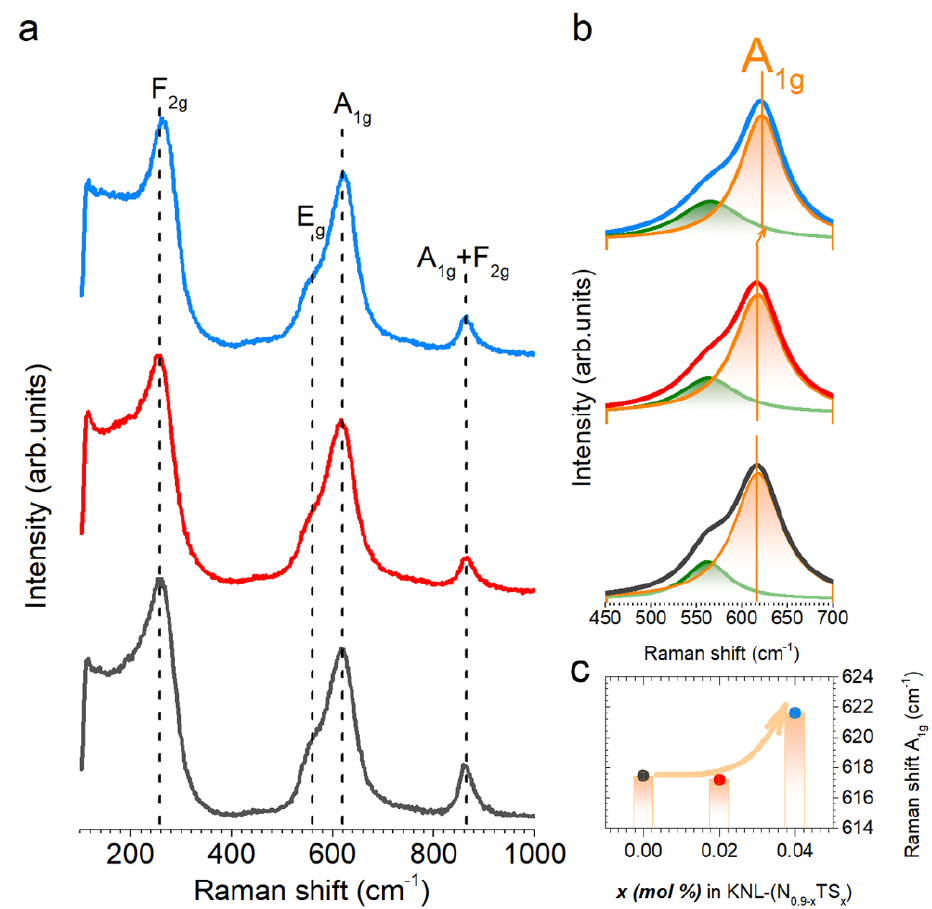
Figure 2. Raman spectra of KNL − (N0.9 − xTSx) ( x = 0.00 to 0.04) sintered samples ( a ), the position of the υ 1 band as a function of Sb concentration ( b ), and Raman shift evolution of the A1g Raman mode of the KNL − (N0.9 − xTSx) ceramics as a function of x ( c ).